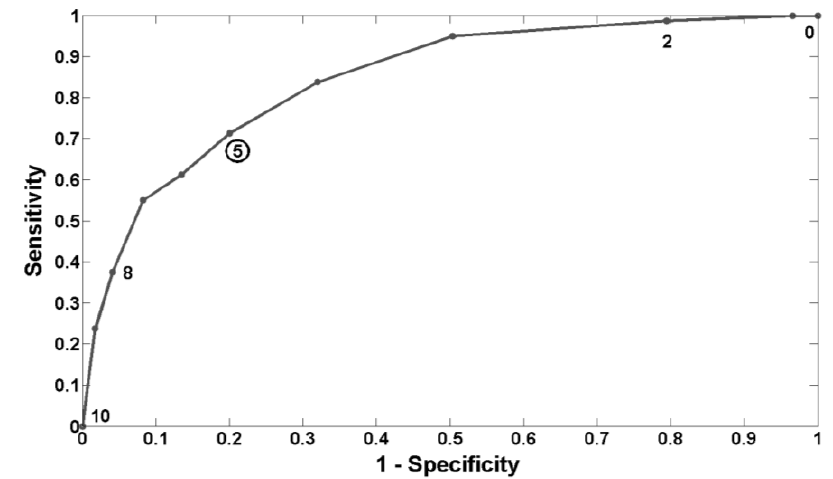
Figure 5. ROC curve with “lapsing” as parameter. Each dot on the ROC curve represents a threshold of POG-based level of drowsiness (0–10). The dot with the circled value (5) is the best compromise between sensitivity and specificity.